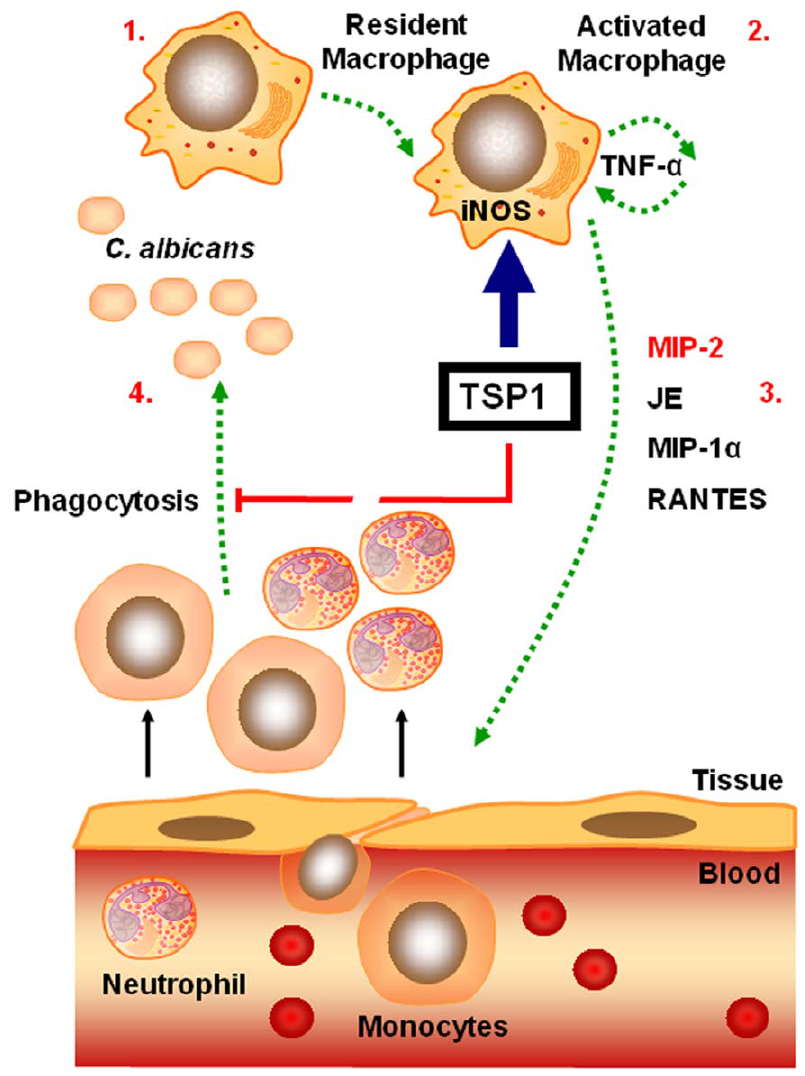
Figure 7. Model for the role of TSP1 in the pathogenesis of disseminated candidiasis. TSP1 is rapidly released at sites of acute infection and inflammation and promotes activation of inflammatory macrophages (iNOS + , IL-6 high , TNF- a high , IL-10 low ) (1–2). TNF- a stimulates PMN recruitment by up-regulating the expression of specific chemokines such as MIP-2, JE, and MIP-1 a (2–3). This initial influx of PMN precedes the extravasation of inflammatory monocytes that amplify the inflammatory response. In addition, TSP1 inhibits the phagocytic function of inflammatory leukocytes (3–4). Thus, TSP1 promotes a sustained recruitment and activation of leukocytes that leads to tissue damage while reducing phagocytic function and fungal